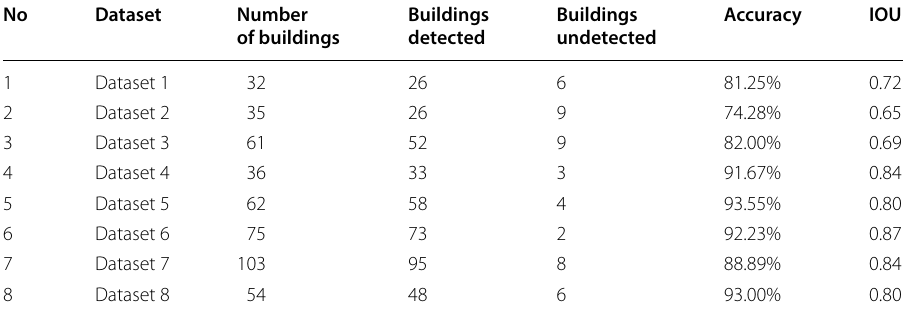
Euclidean clustering results +